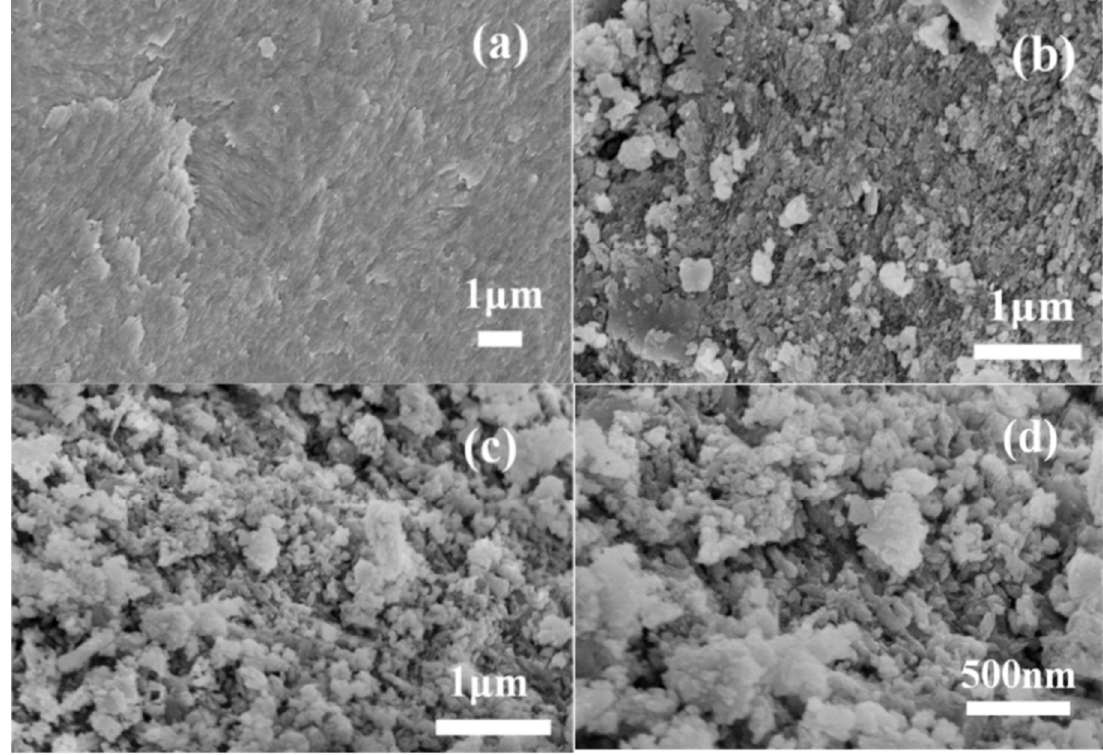
Figure 2. Surface morphologies of raw fishbone (RFB) ( a ), carbonized fishbone (FBC) ( b ), and MAFC with di ff erent magnifications ( c , d ).